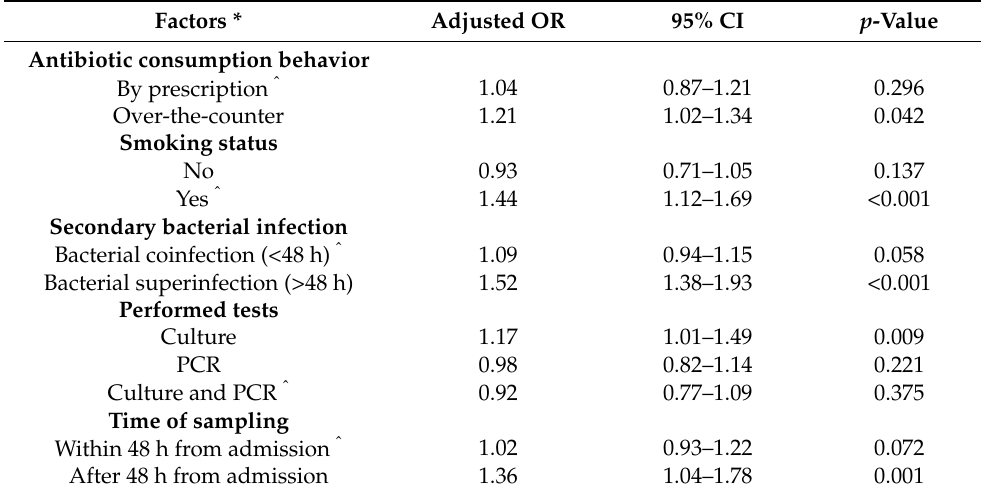
Table 6. Risk factor analysis for prolonged hospitalization in COVID-19 patients with secondary bacterial infections self-medicated with